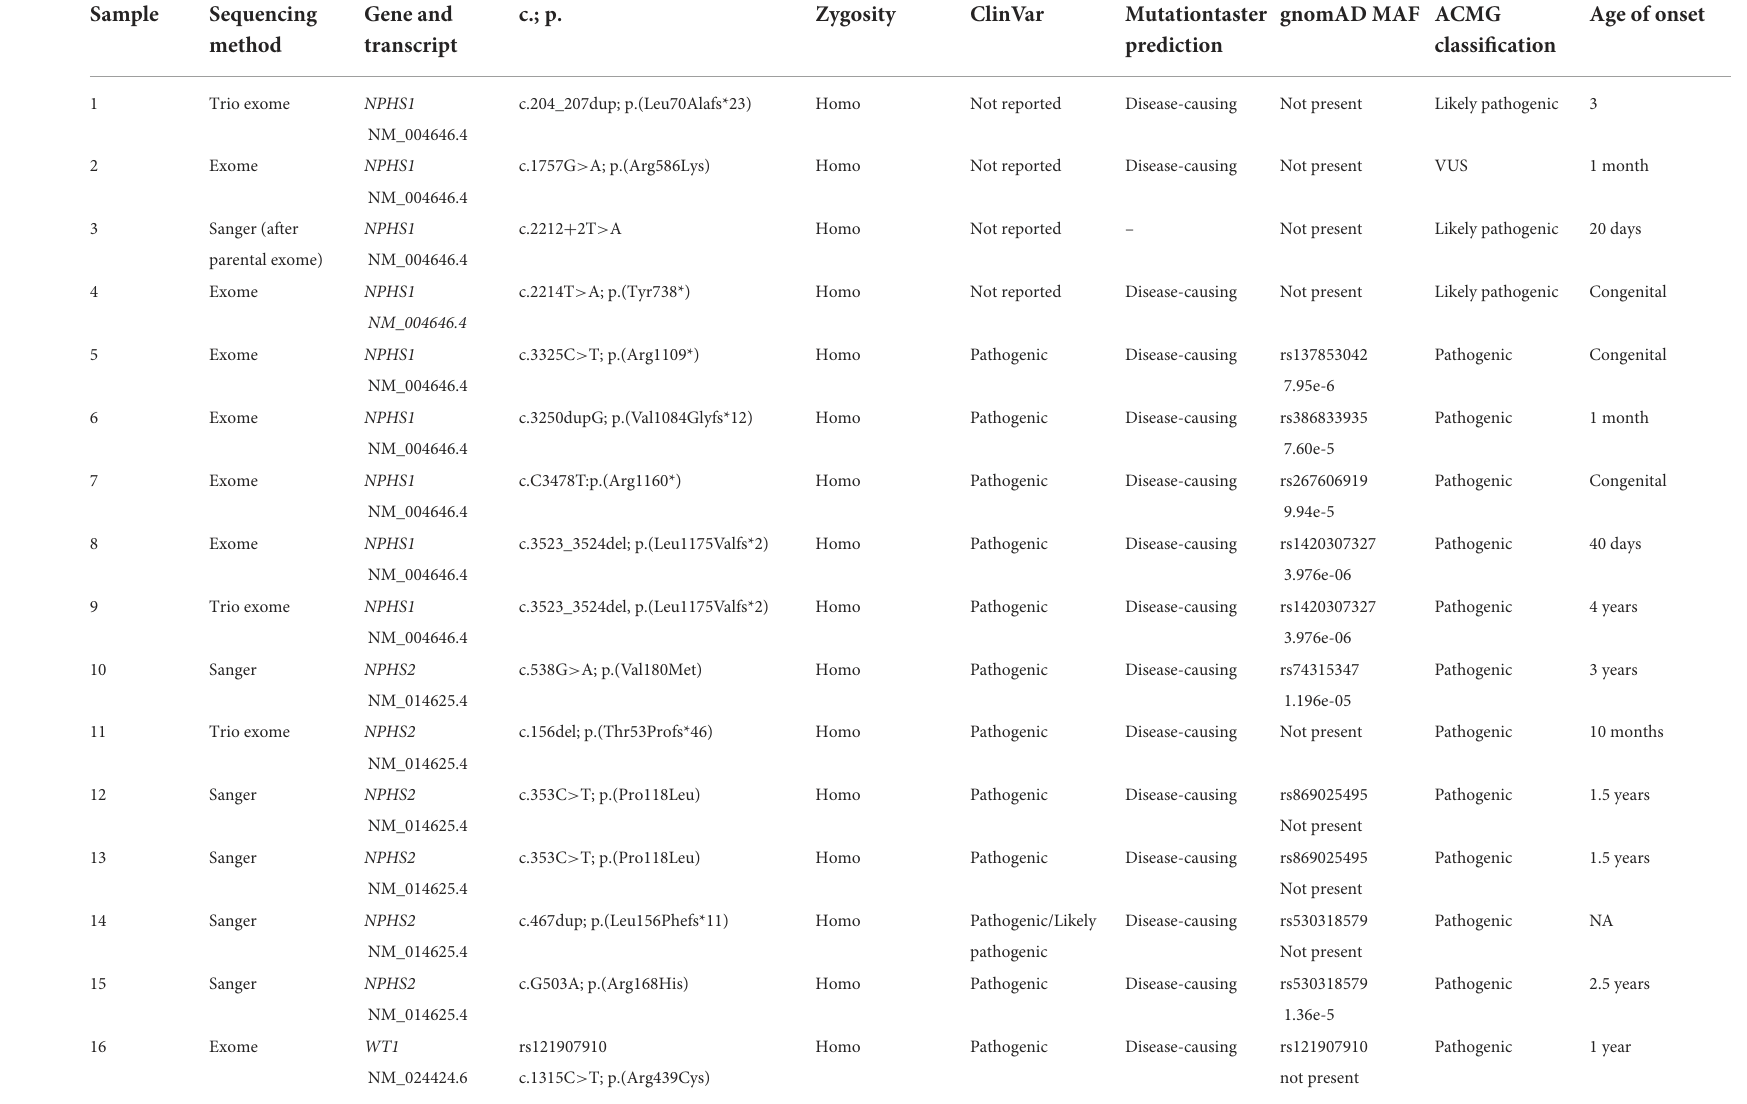
TABLE 1 Summary of genetic